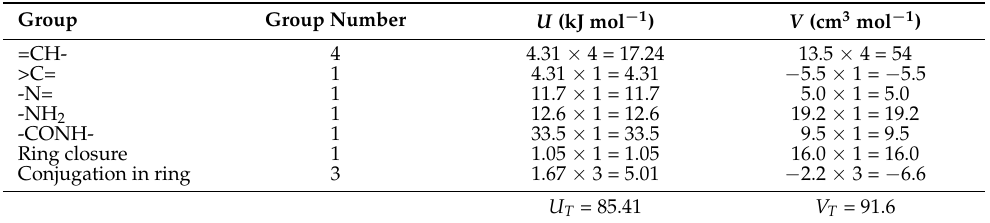
Table 2. Isoniazid solubility parameter calculated according to the Fedor’s